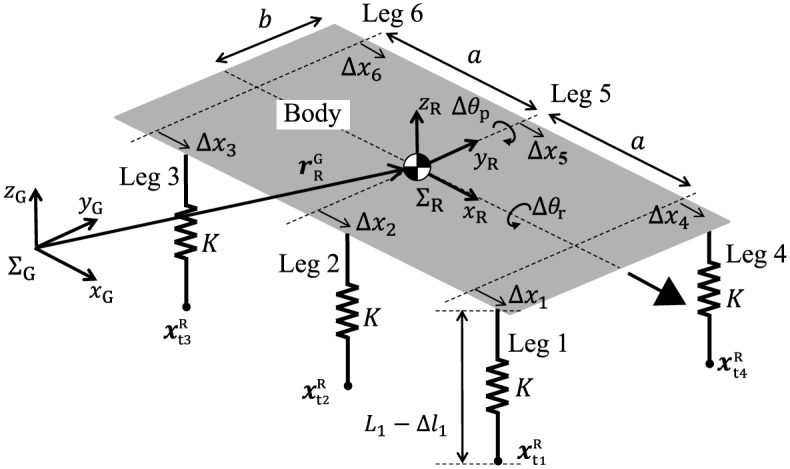
Simple physical model with rigid body and six massless spring legs.The body is represented by a flat plate here to show the geometric relationships between the model and the variables more clearly.